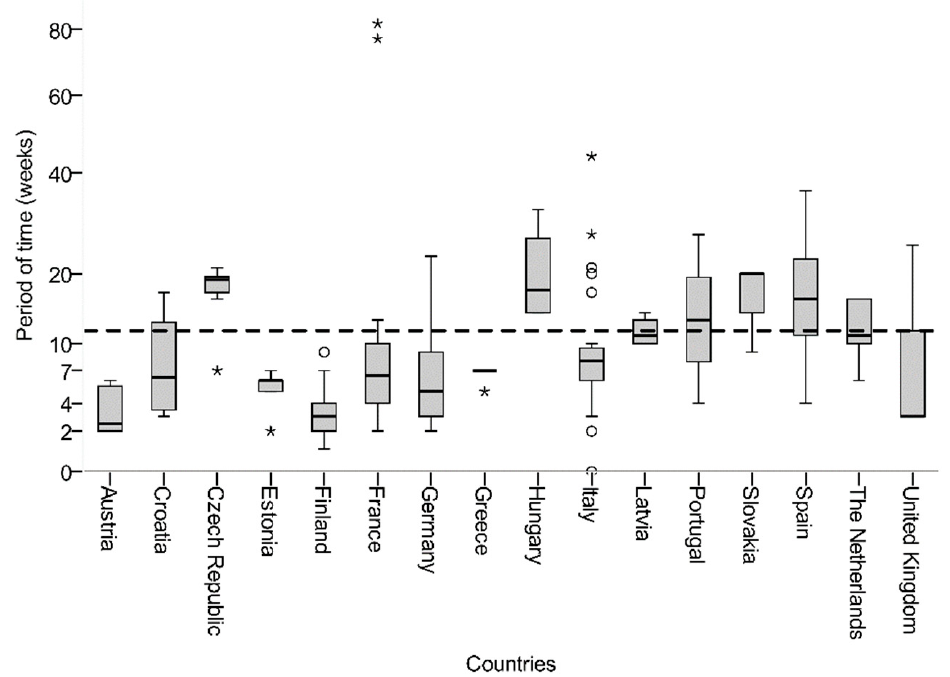
Figure 3. Boxplot graph presenting the time period between completed microbiological examination (national laboratory report) and publication date of the corresponding RAPEX notification, shown by country. The black dashed line represents the mean diagnostic delay of 11.6 weeks (standard deviation ± 10.4 weeks) for all reported products with available national laboratory reports ( n = 209). The circles define outliers with values between 1.5 and 3 times the height of the boxes. Asterisks display extreme outliers, representing cases with values of more than three times the height of the boxes.